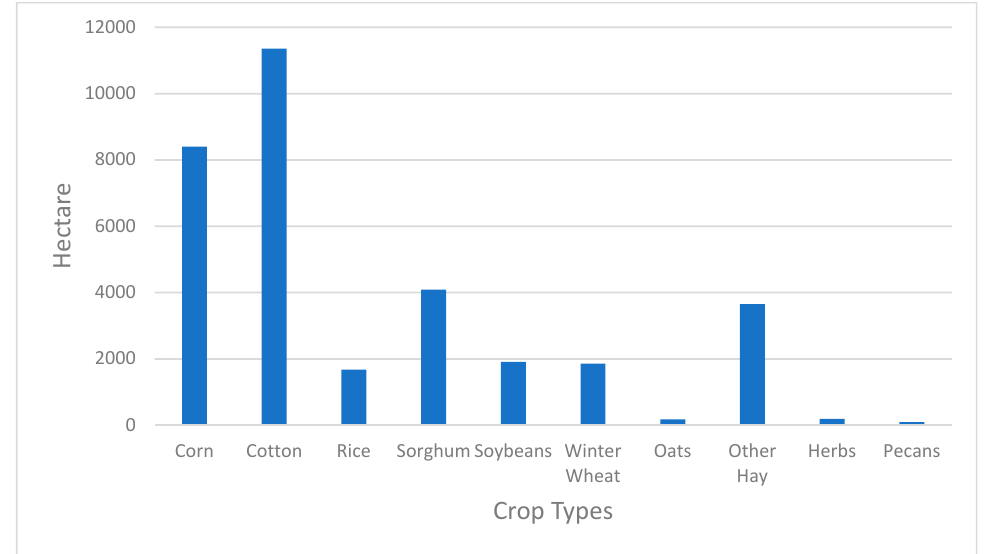
Figure 13. Comparison of SMAP derived inundation acreage of the Texas Flood (May 2016) over major crop types.